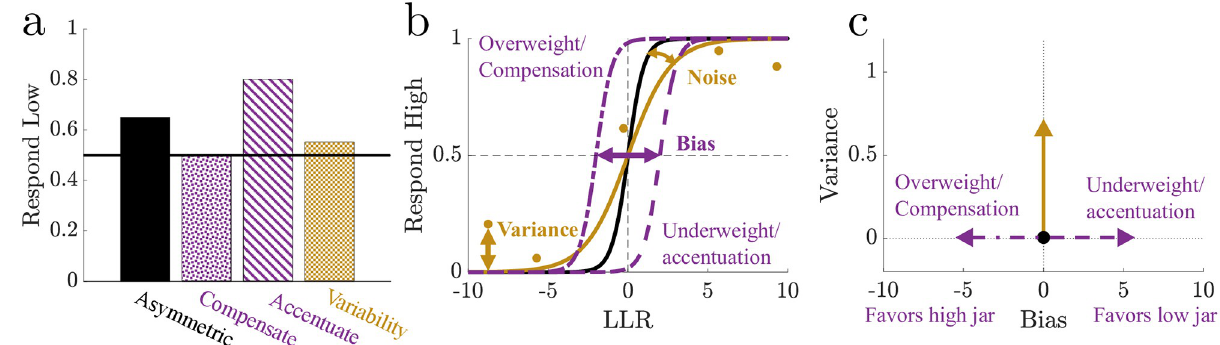
Fig 2. Suboptimalities are reflected by the psychometric function. a. Illustration of how suboptimalities, such as mistuned ball weights or biased priors, compensate for (overweighting, bias in favor of high jar) or accentuate (underweighting, bias in favor of low jar) choice asymmetry in environments with asymmetric evidence, whereas increases in variability (inclusion of noise and/or variance) have a small impact on choice asymmetry. b . Examples of how a psychometric function fit to data is modulated by suboptimalities. An increase in noise decreases the slope, and a bias results in a horizontal shift of the psychometric function. We define variance as the mean absolute error between the best–fit psychometric function and the data, representing systematic aspects of strategies unaccounted by the LLR. c . Schematized bias-variance space showing how suboptimal bias and variance shift an observer’s location in bias-variance space. Bias was bounded between [ − 10, 10] to mitigate overfitting due to outliers. Positive (negative) biases corresponded to more (fewer) low-jar selections.